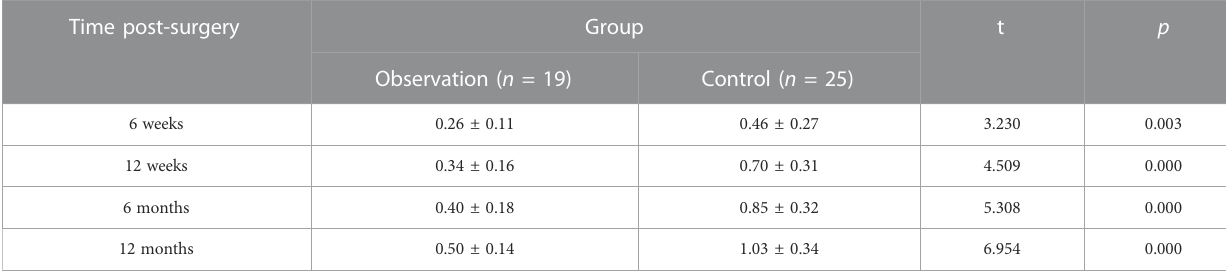
Data are expressed as mean ± SD.